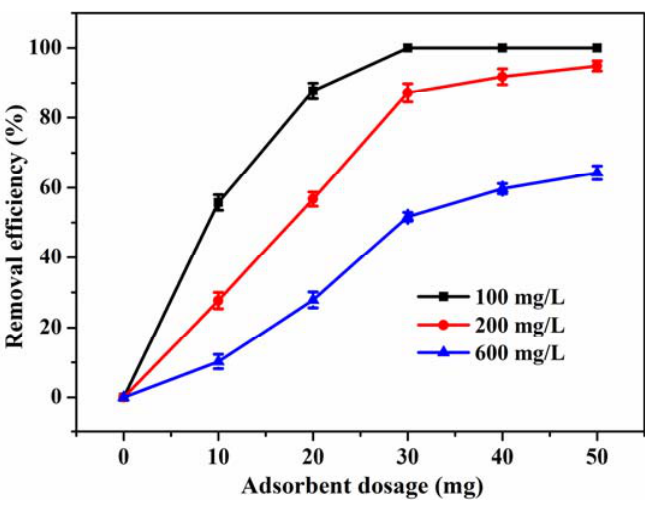
Figure 7. The influence of adsorbent dosage on removal efficiency of RhB by CBC ‐ Fe(II).